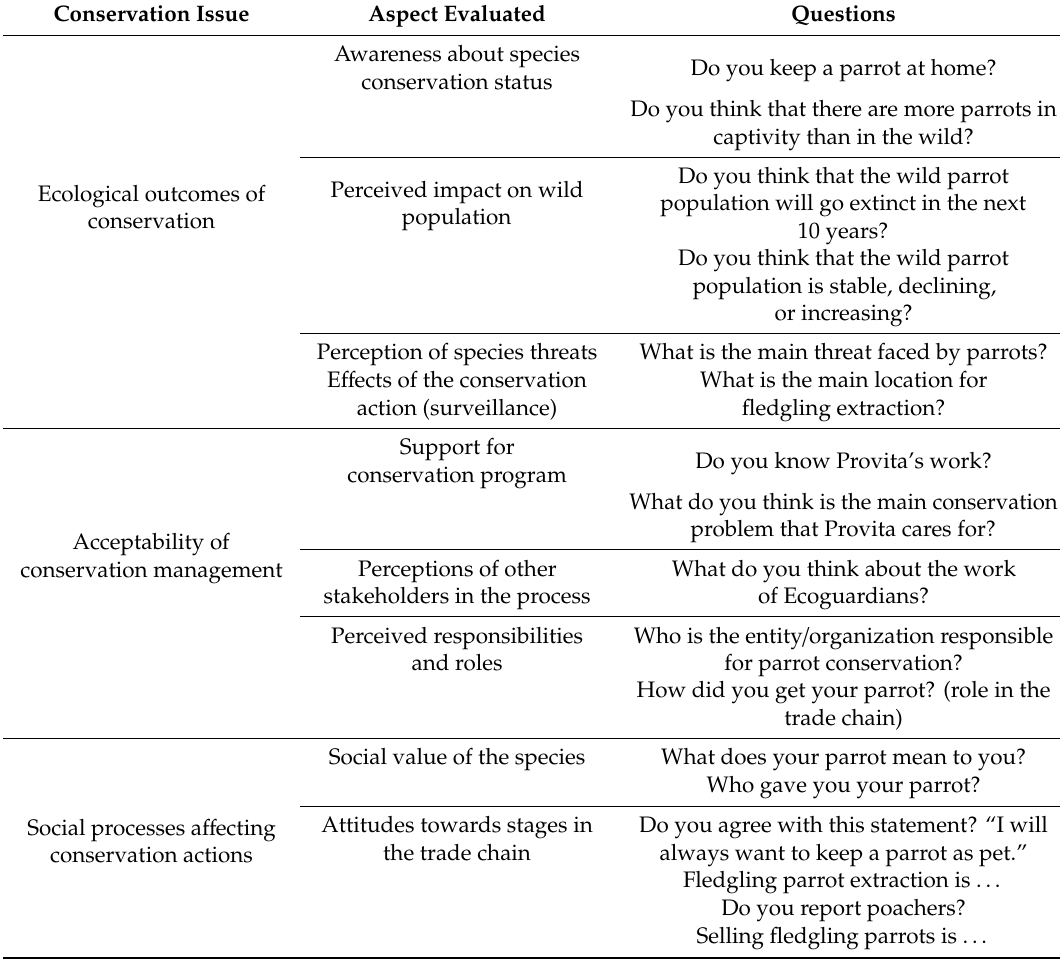
Table 1. Evaluation of the yellow-shouldered Amazon Conservation Program, based on perceptions in three communities of the Macanao Peninsula, Margarita Island,